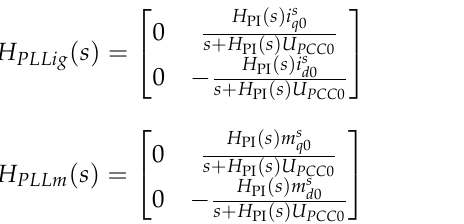
Figure 2. The small-signal control block diagram of the inverter considering the influence of MFOF-PLL. In Figure 2, the transfer functions for each link are shown as